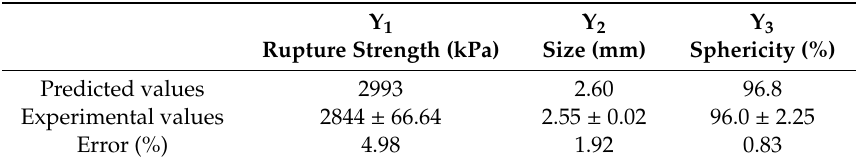
Table 9. Experimental and predicted results of verification under optimized